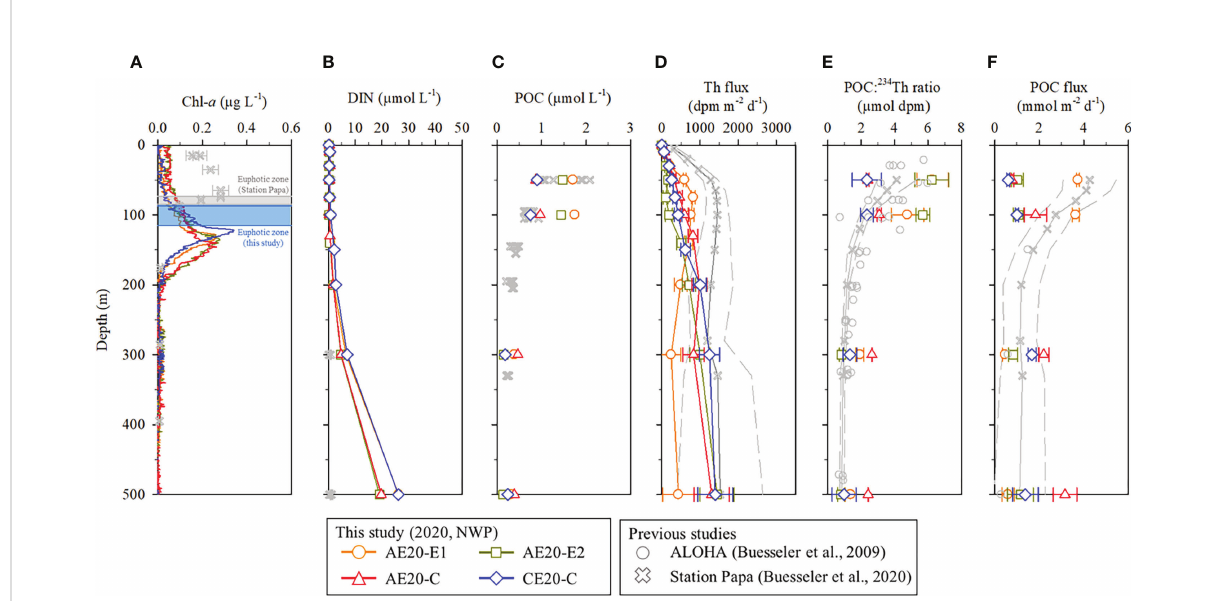
FIGURE 5 Vertical distributions in the upper 500 m layer of (A) Chl- a , (B) DIN, (C) POC, (D) 234 Th fl ux, (E) POC: 234 Th ratio, and (F) POC fl ux in the tropical northwest Paci fi c in September 2020. The data for comparison are from Buesseler et al. (2009b) and Buesseler et al.